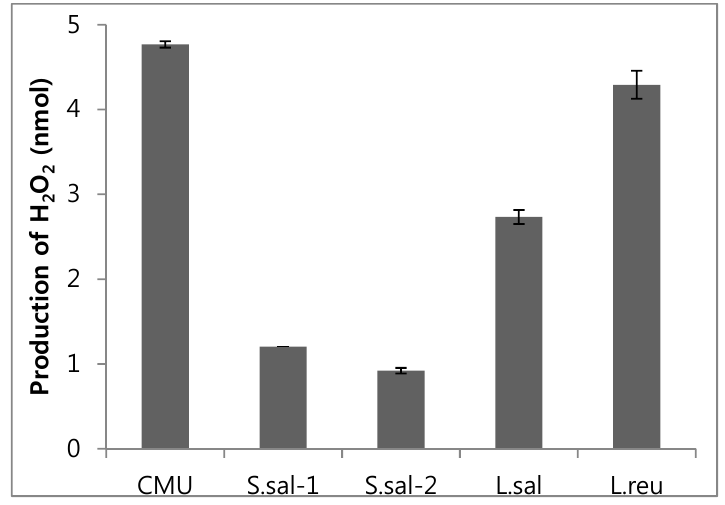
Figure 2. Hydrogen peroxide production activity of probiotics.